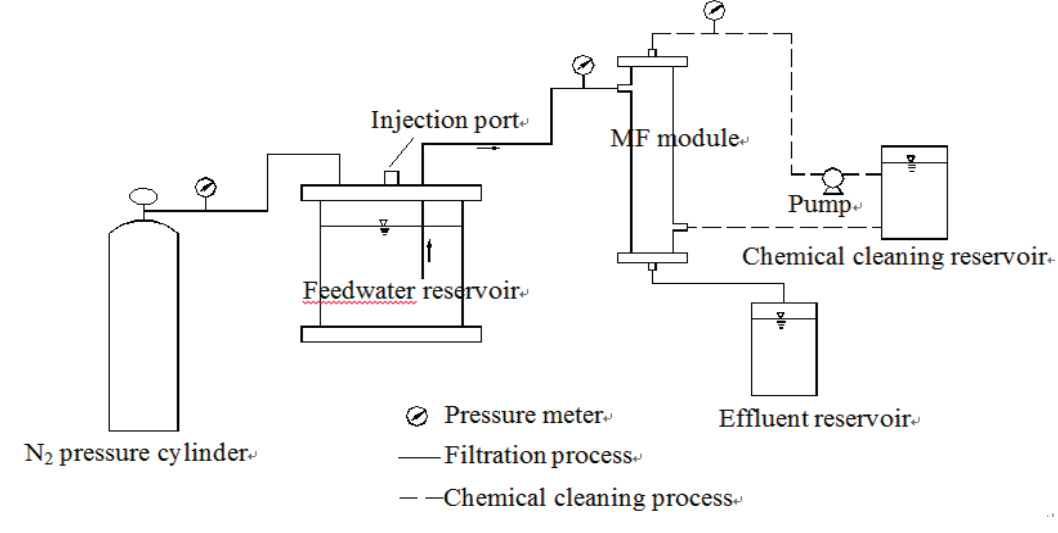
Figure 1. Schematic of microfiltration (MF) filtration